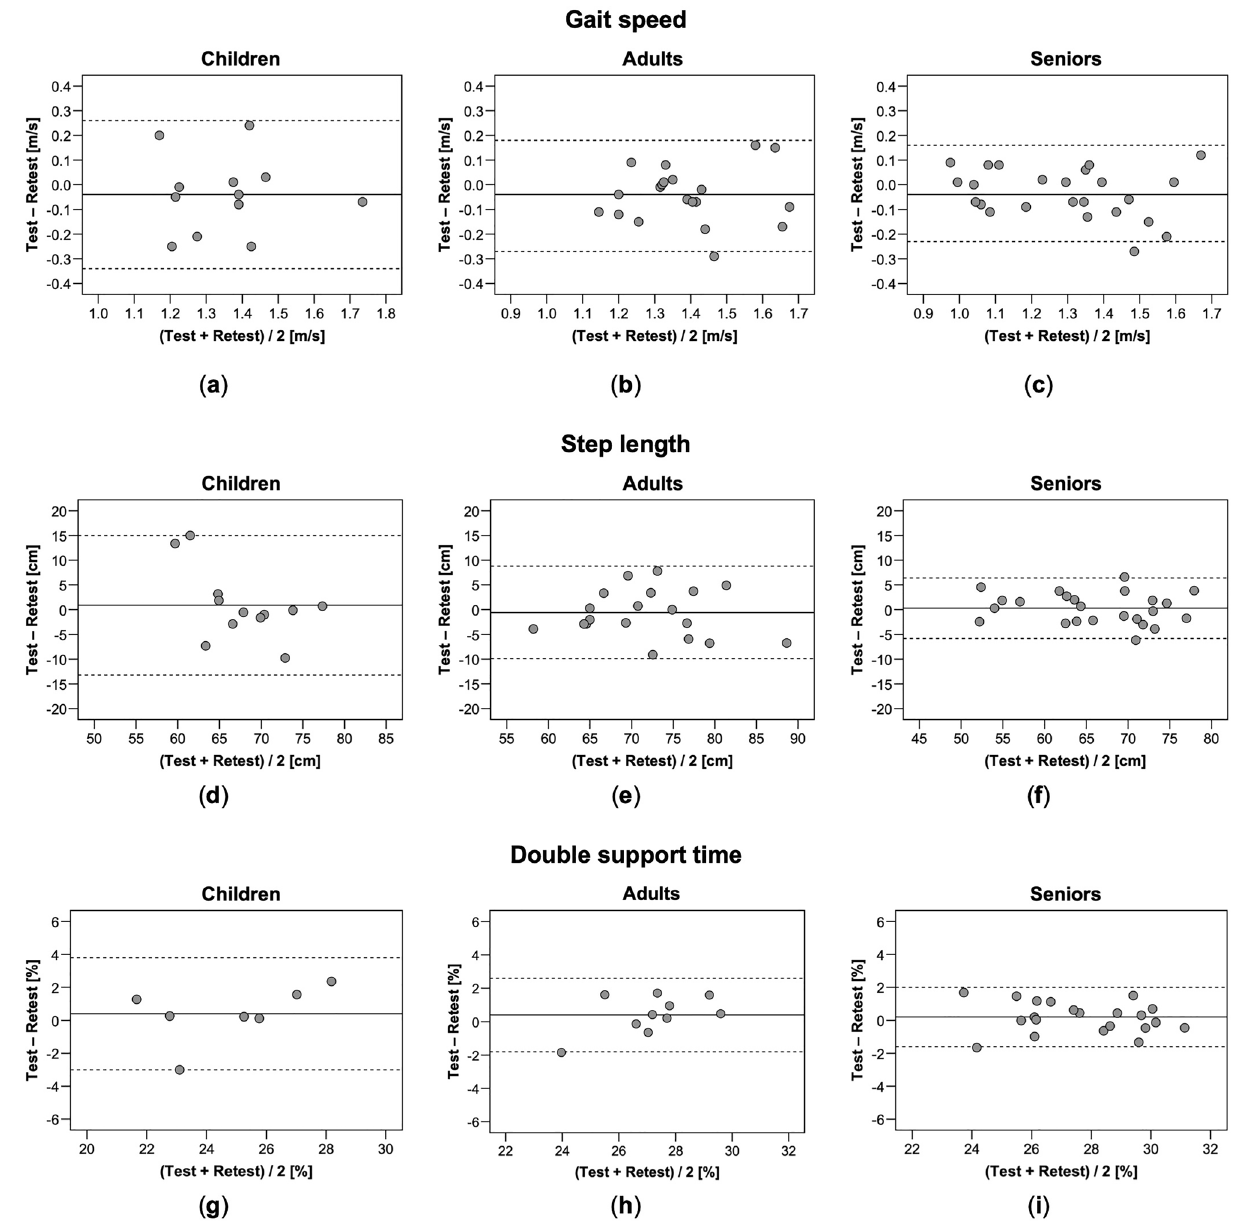
Figure 2. Bland–Altman plots for repeated measurements of gait speed ( a – c ), step length ( d – f ) and double support time ( g – i ) measured with the Health app in children, adults, and seniors. Solid lines indicate mean between-method differences (bias) and dashed lines indicate upper and lower 95% limits of